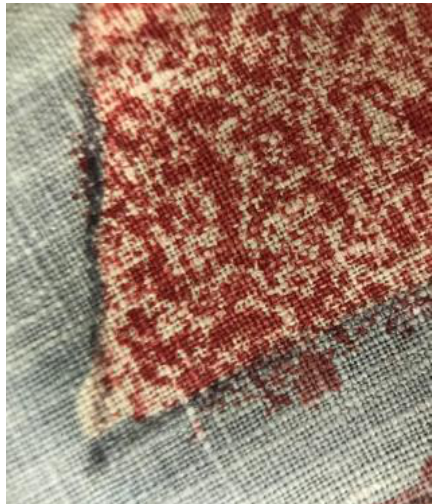
Figure 13. Detail of curtain from a set of bed hangings in the style of Jean B é rain; Chintz, cotton tabby, painted, mordant-dyed, resist-dyed, painted details, glazed, made in coastal southeast India